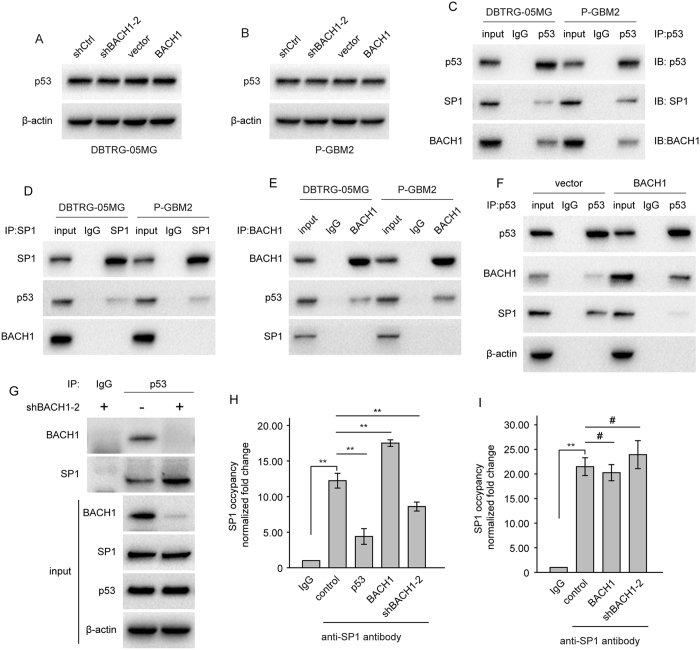
BACH1 affects the expression of MGMT through impairing the association between p53 and SP1.(A) Western blot analysis of p53 expression in DBTRG-05MG cells transfected with BACH1 expression plasmid or shBACH1-2. (B) Western blot analysis of p53 expression in P-GBM2 cells transfected with BACH1 expression plasmid or shBACH1-2. (C–E) Lysates from GBM cells were incubated in the presence of anti-IgG, or anti-p53, or anti-SP1, or anti-BACH1 antibody. Immunoprecipitated material was subjected to SDS-PAGE, and Westernblot analysis was performed with anti-p53, anti-SP1 and anti-BACH1 antibodies. (F,G) Co-IP was performed using lysates prepared from DBTRG-05MG cells transfected with BACH1, or vector control, or shBACH1-2, or shCtrl using anti-IgG or anti-p53 antibody. And Westernblot analysis was performed with indicated antibodies. (H) DBTRG-05MG cells were separately transfected with wild-type p53, shBAHC1, or BACH1. ChIP assays were performed using anti-IgG or anti-SP1 antibody. The eluted DNA was subjected to qRT-PCR with the specific primer set for the MGMT promoter region. (I) DBTRG-05MG cells stably expressing shp53 were separately transfected with shBAHC1 or BACH1. ChIP assays were performed using anti-IgG or anti-SP1 antibody. The eluted DNA was subjected to qRT-PCR with the specific primer set for the MGMT promoter region. Student’s t-tests and One-way ANOVA were performed. Data are presented as mean ± SEM (**P < 0.01, #P > 0.05).